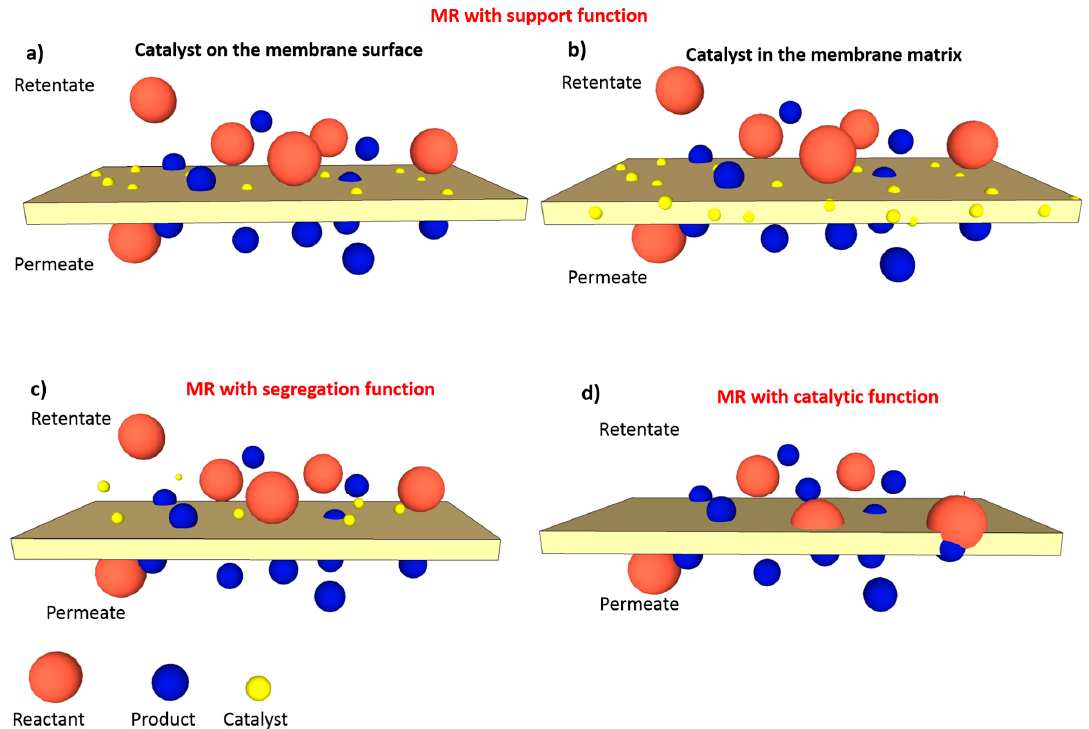
Figure 1. Possible functions of a membrane in a membrane reactor: Membrane as a catalyst support located on the surface ( a ) or within the matrix ( b ); membrane with segregation function ( c ) and membrane with catalytic function ( d ).